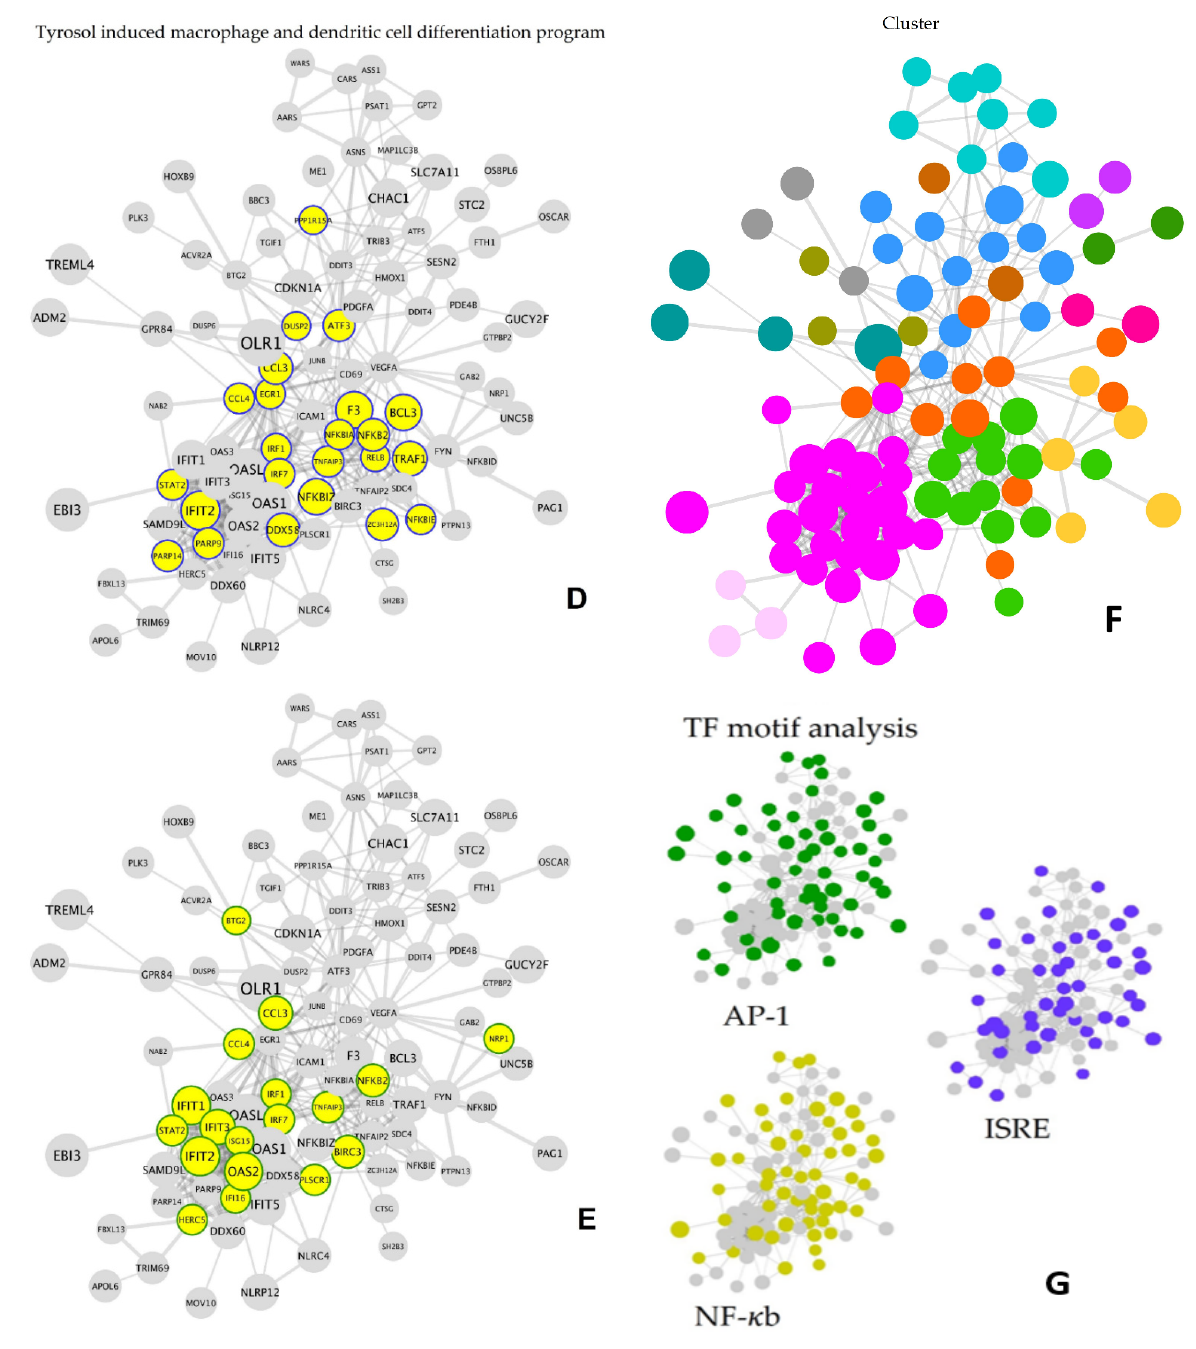
Figure 8. ( A – C ): Tyrosol induces monocyte lineage gene program. Gene expression analysis of tyrosol at 1, 6, and 12 h using RNA-seq as described in Methods. ( A , B ) Hierarchical clustering of Heat Map showing relative expression of negative ( A ) and positively expressed genes ( B ).Scale bar depicts z-score relative expression. ( C ) The network plot is based on known and predicted interactions from the STRING database (v11), with minimal confidence score of 0.4. Node size represents Fold change over untreated cells in two independent experiments. Nodes with magenta border represent genes involved in Myeloid differentiation process. Scale bar depicts –log10 of p -value. ( D – G ): ( D ) Network depicted in ( C ) with nodes involved in monocyte-derived macrophage gene program highlighted in yellow and blue border. ( E ) Network depicted in ( C ) with nodes involved in monocyte-derived dendritic gene program highlighted in yellow and green border. ( F ) Modules identified in protein network shown in ( C ) determined using the Markov Cluster algorithm (inflation parameter: 2.5). Each colour represents a separate module (associated adjacency matrix). ( G ) DAVID analysis of network depicted in ( C ) showing enrichment of NF- κ b (yellow), AP-1 (green), and ISRE (blue) binding sites in gene promoters of the